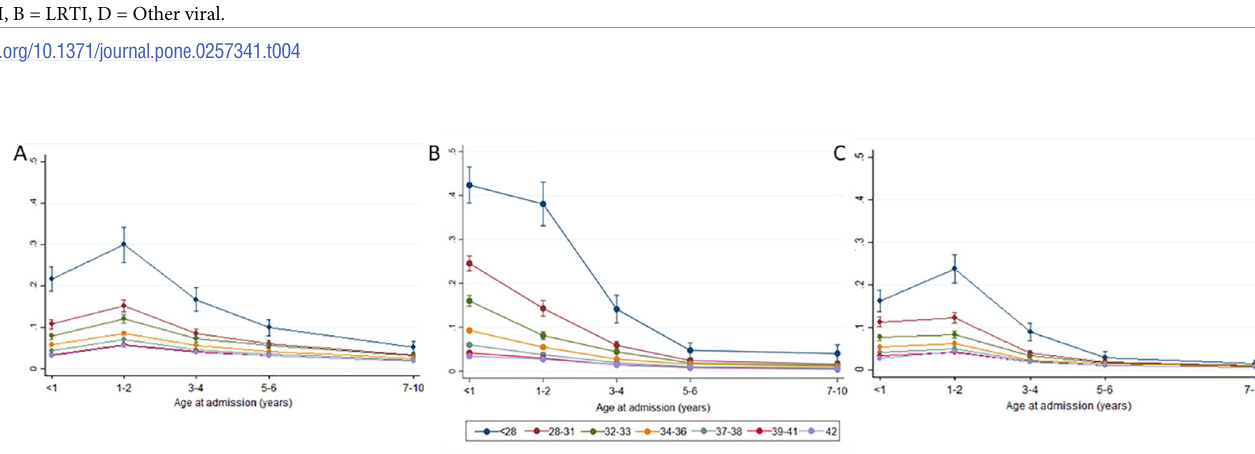
Fig 4. Estimated mean number of hospital admissions per child by gestational age at birth and age at admission by infection subgroups, adjusted for: Maternal age at birth; marital status; Index of Multiple Deprivation (IMD) quintiles; baby’s ethnicity; mother’s country of birth; mode of birth; parity; month of birth, baby’s sex; and